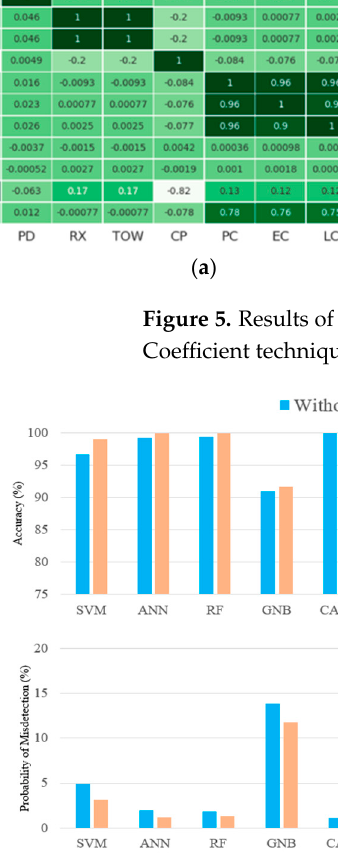
Figure 6. Impact of data correlation on model performance.